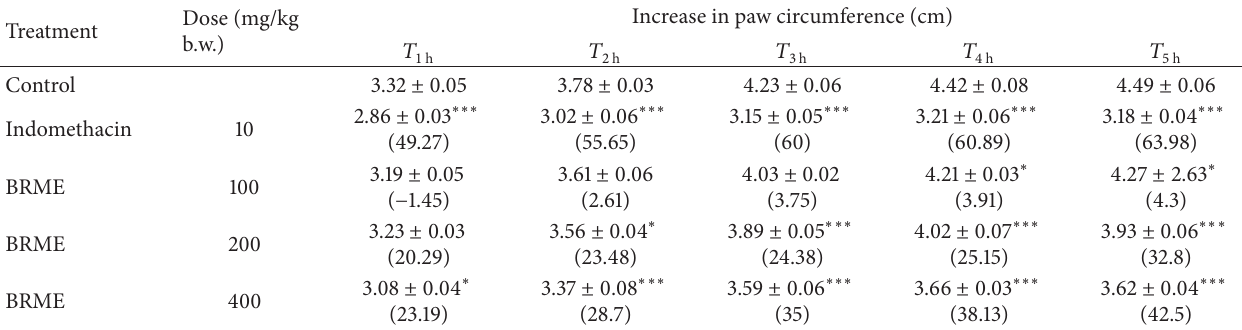
Table 1: Effect of methanolic extract of fruit of Bridelia retusa on carrageenan-induced paw oedema. Treatment